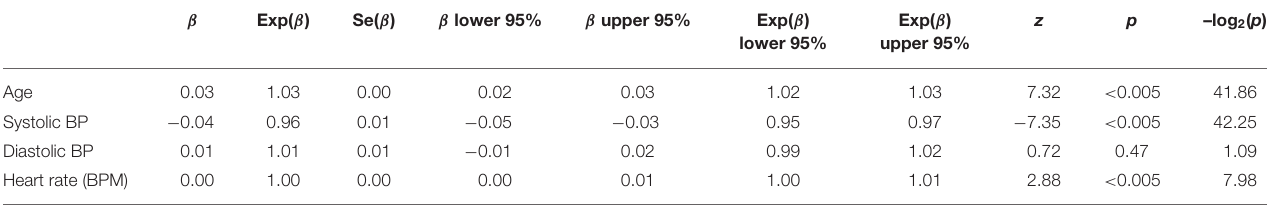
TABLE 4 | Summary of Age_Cox_model.